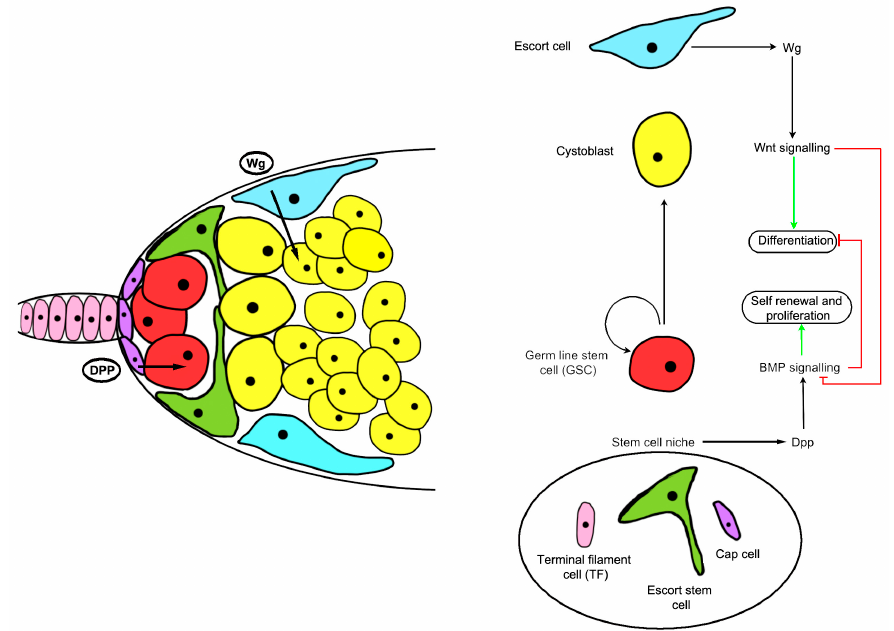
Figure 2. Structure and signaling mechanisms of the Drosophila ovarian germline stem cell (GSC) niche. Cap cells (purple) and escort stem cells (green) function as a niche to maintain GSCs (red), allowing germ cells outside the niche to differentiate. A schematic diagram showing that wingless (Wg) signals control inner germarium sheath cells (IGC) maintenance and promote germ cell differentiation by preventing bone morphogenetic protein (BMP) signaling. Dpp: Decapentaplegic.